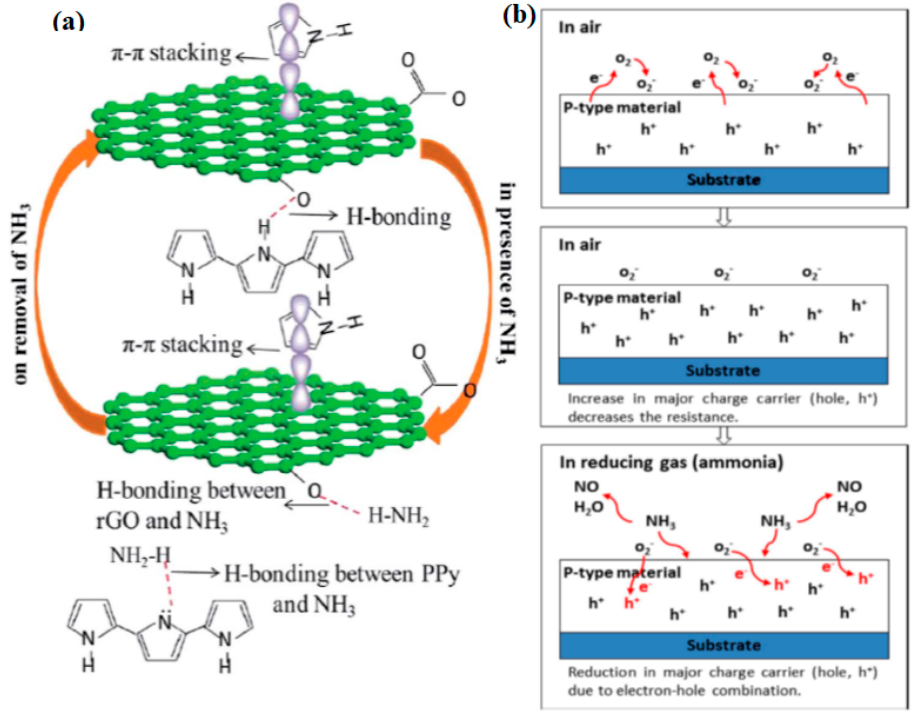
Figure 16. Sensing schematic interaction of ( a ) Ppy/rGO hybrid with NH 3 . Reprinted with permission from [299]. Copyright RSC 2018. ( b ) The sensing mechanism of the p-type material in air and reducing gas environments. Adapted with permission from [275]. Copyright IOPScience 2019.